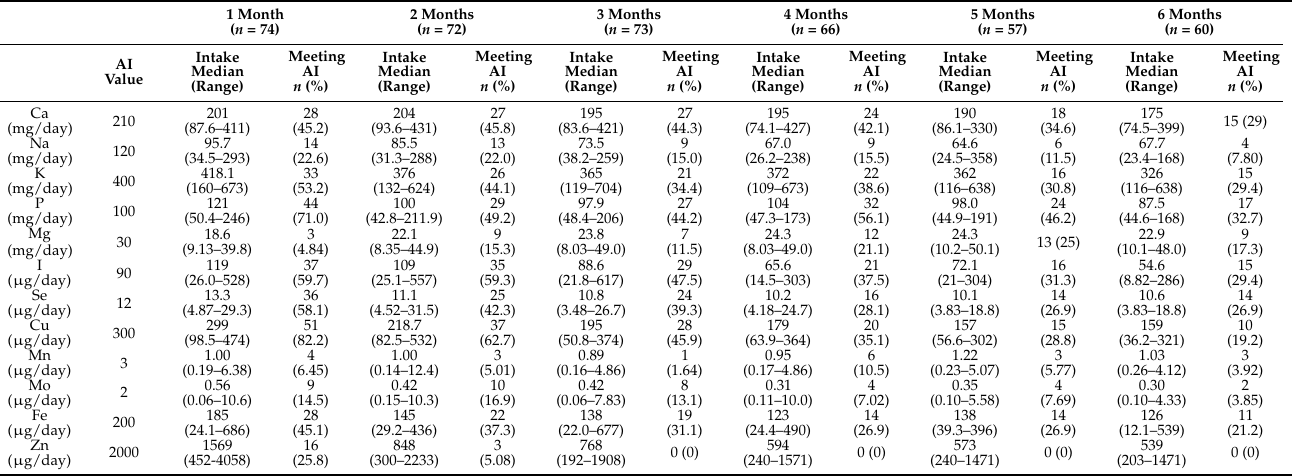
Table 2. Median intakes of macro- and trace elements at 1–6 months pp compared to recommended AI (Adequate Intake) values. Data shown as median (range) for measured intakes and number (percentage) for infants meeting the AI. Infant intake expressed as median (range). Infants meeting AI expressed as n